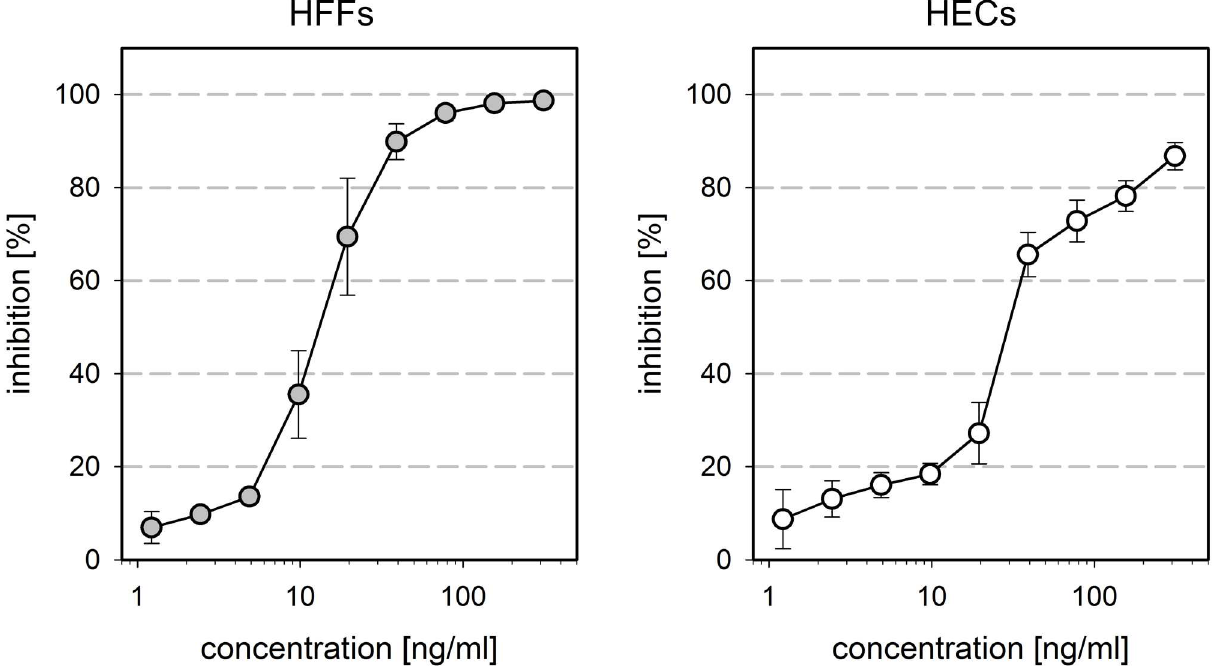
Fig 2. Inhibitory effect of soluble PDGFR-alpha-Fc chimerason HCMV infection. Virus preparations of strain TB40/E were pretreated for two hours with PDGFR-alpha-Fc at indicatedconcentrations and then added to fibroblasts(HFFs) and endothelialcells (HECs). One day after infection, cells were fixed and stained for viral IE antigens by indirectimmunofluorescence. The ratio of IE antigen-positive cells per total cell numberwas calculatedto represent the degreeof infection. The graphsshow the inhibitionof infectionin treated cultures as comparedto untreatedcontrols. Error bars represent the standarderror of the mean